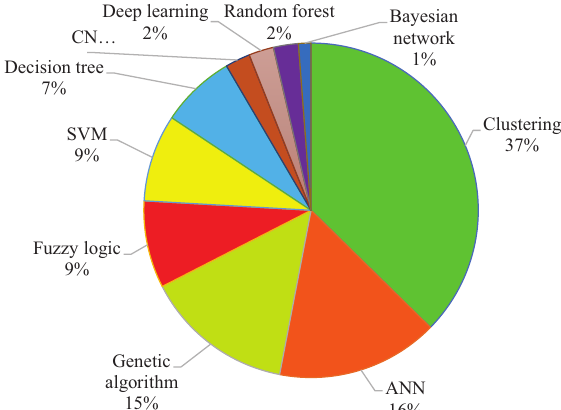
Figure 8. Applications of AI techniques in